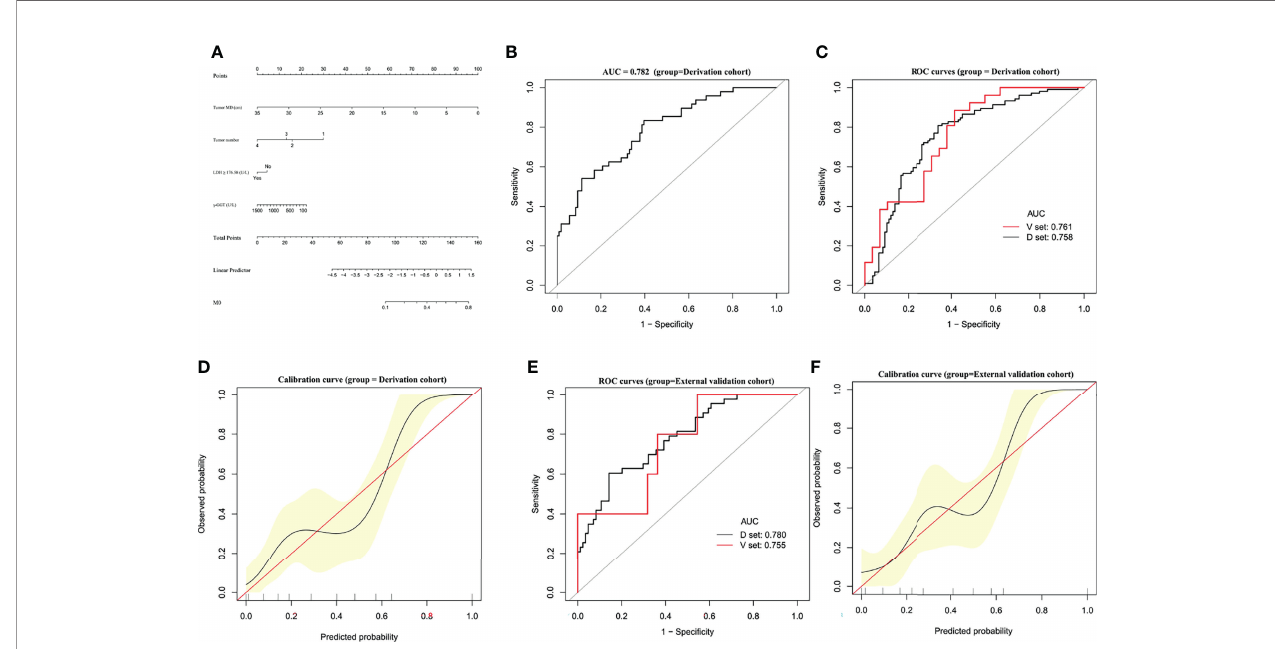
FIGURE 4 | Establishment and validation of M0 predictive nomogram for HCC patients. (A) M0 prediction scores are calculated with this four-factor nomogram exactly as in Figure 2A . (B) M0 nomogram AUC = 0.782 (95% CI, 0.7044 – 0.8597). (C) Bootstrap analysis for internal validation and (D) GiViTI calibration plots showing good prediction-observation agreement for M0 in the derivation cohort. (E) Bootstrap analysis for internal validation and (F) GiViTI calibration plots showing good prediction-observation agreement for M0 in the external validation cohort. AUCs are shown in the fi gure and reported with 95% CIs in the text together with the c-index. GiViTI calibration plots showing good prediction-observation agreement for M0 in the derivation (D) and external validation (F) cohorts. Calibration plots (black lines) show fi tted polynomial logistic function curves of the relationship between the logit transformation of the predicted probabilities and empirical outcomes (shaded yellow, 95% CI). Ideal reference lines are red. HL chi-square calibration values for each cohort are reported in the Results